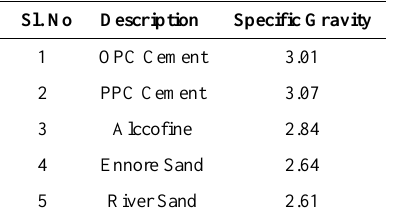
Table 2. Specific gravity of different materials.